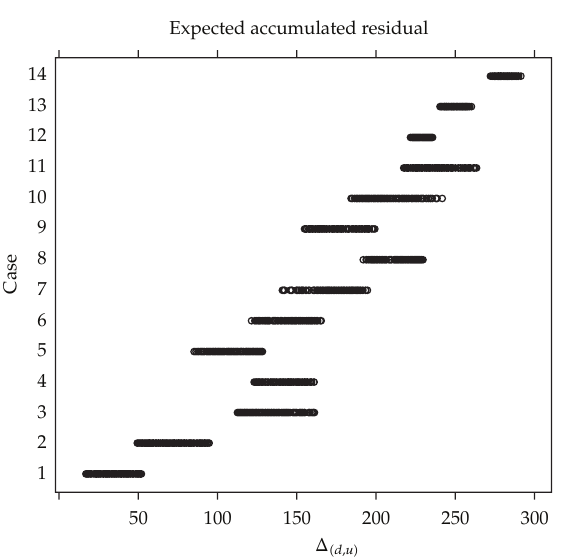
Figure 2: Range of approximate expected accumulated residual Δ (cid:6) d,u (cid:7) values for all cases.